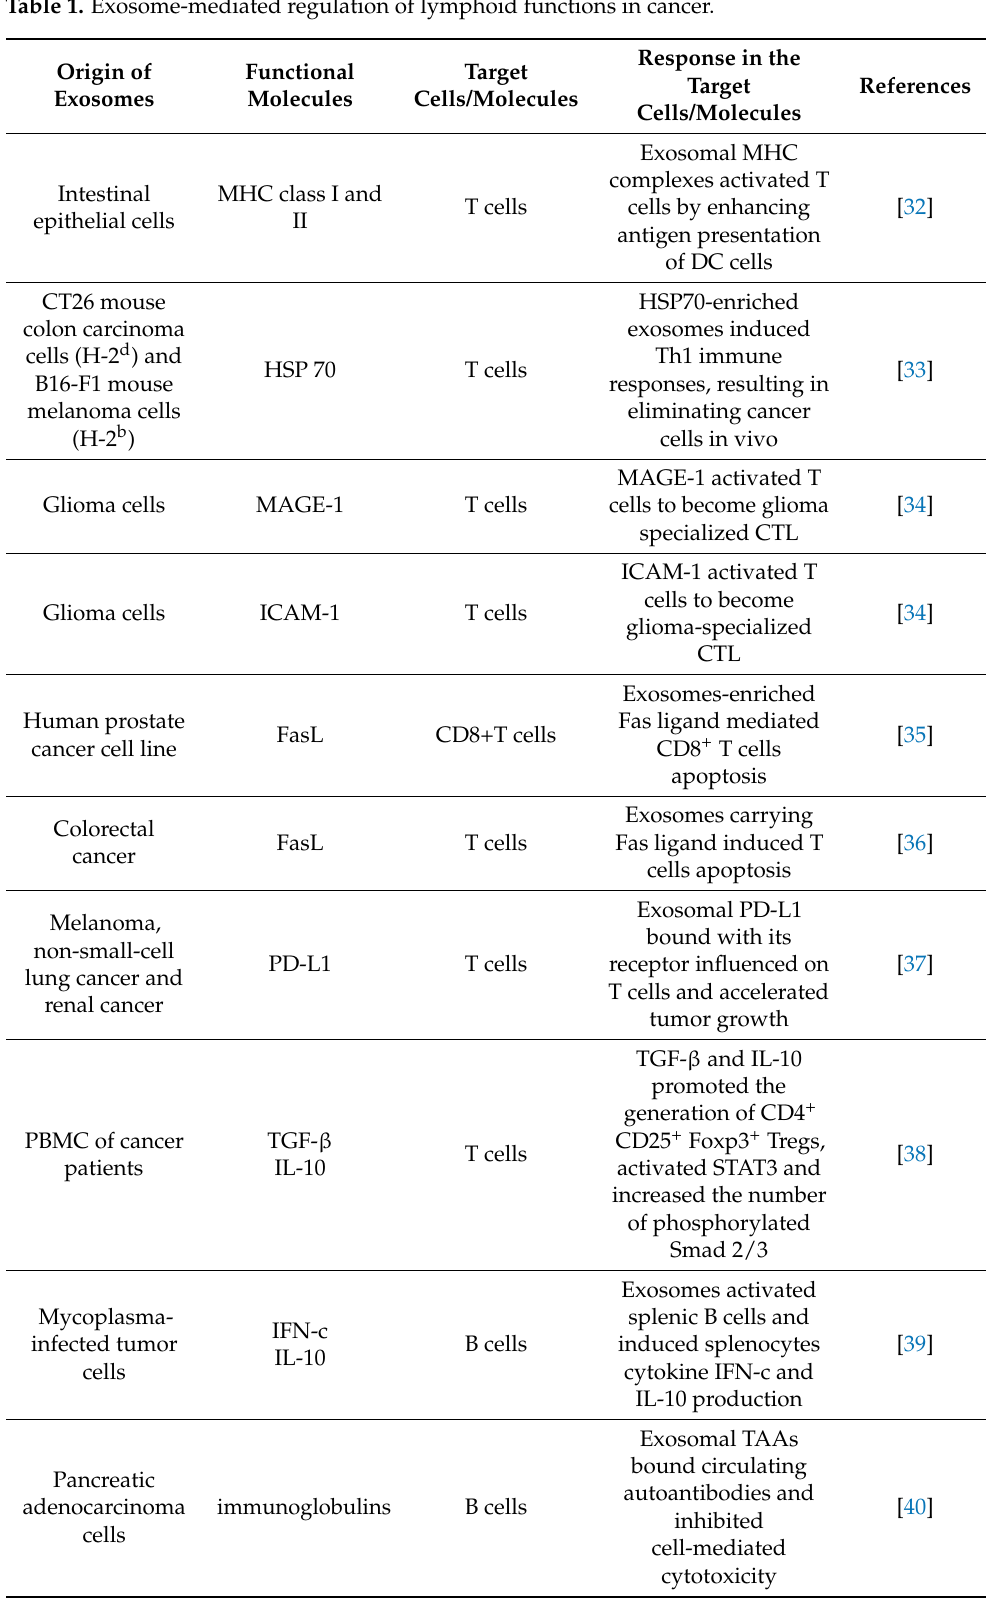
Table 1. Exosome-mediated regulation of lymphoid functions in